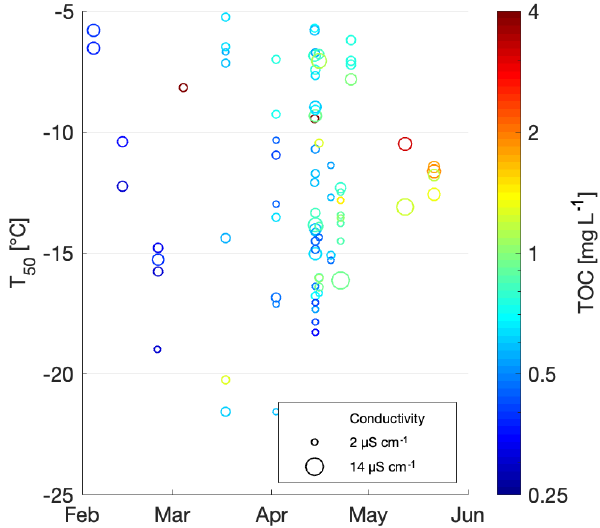
Figure 6. Time series distribution of the T 50 values during the en- tire field campaign, displayed as months in 2018. TOC values of the samples are shown on a color scale and conductivity values are shown on a marker size